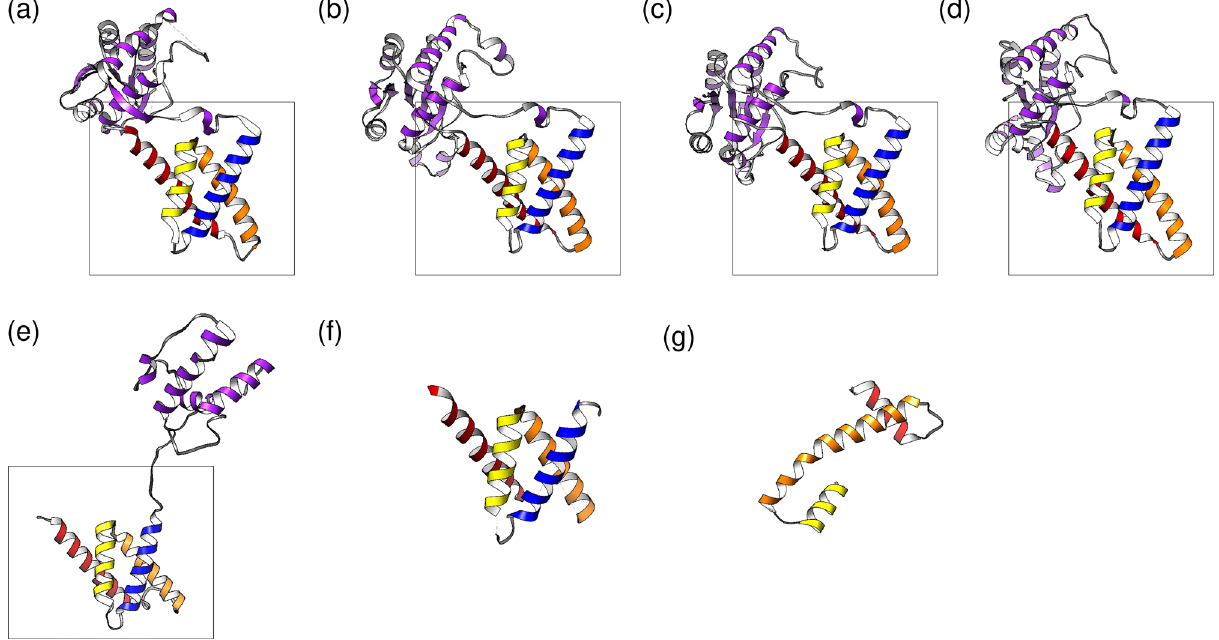
Figure 4. Models of the 3D structure of the KaiA homologs from different cyanobacteria. ( a ) Synechococcus (ABB57248, PDB: 1R8J); ( b ) Trichodesmium (WP_044137784); ( c ) Phormidium (WP_087707133); ( d ) Prochlorothrix (KKJ01719); ( e ) Nostoc (WP_015140002); ( f ) Nostoc (WP_010997035, PDB: 1R5Q); ( g ) Prochlorococcus (WP_036914277). The KaiA domain is boxed. Models ( a ) and ( f ) are experimental, the others are computer generated.